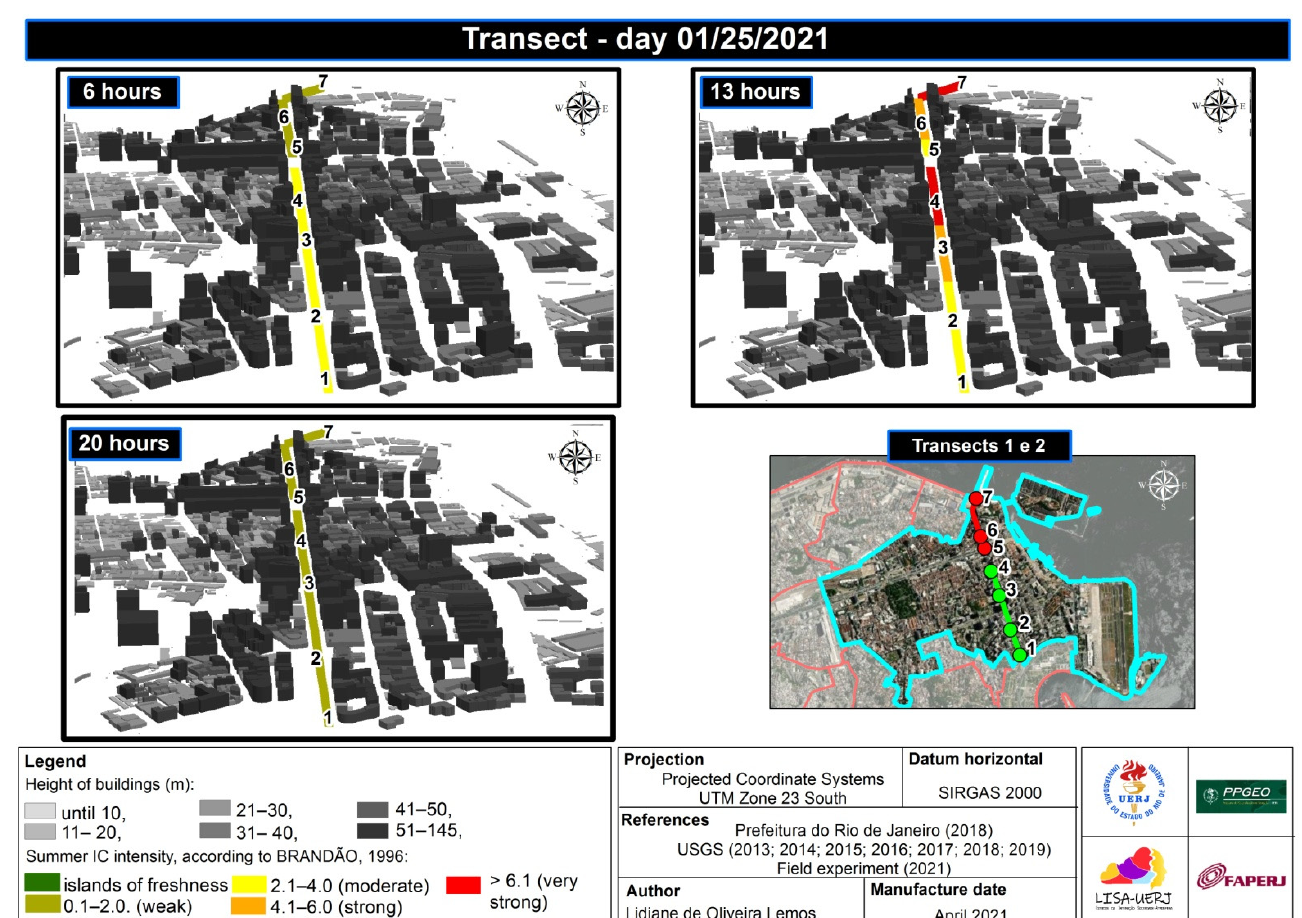
Figure 7. Rio de Janeiro—horizontal thermal field in the urban canyon of Avenida Rio Branco, 25 January (Monday).